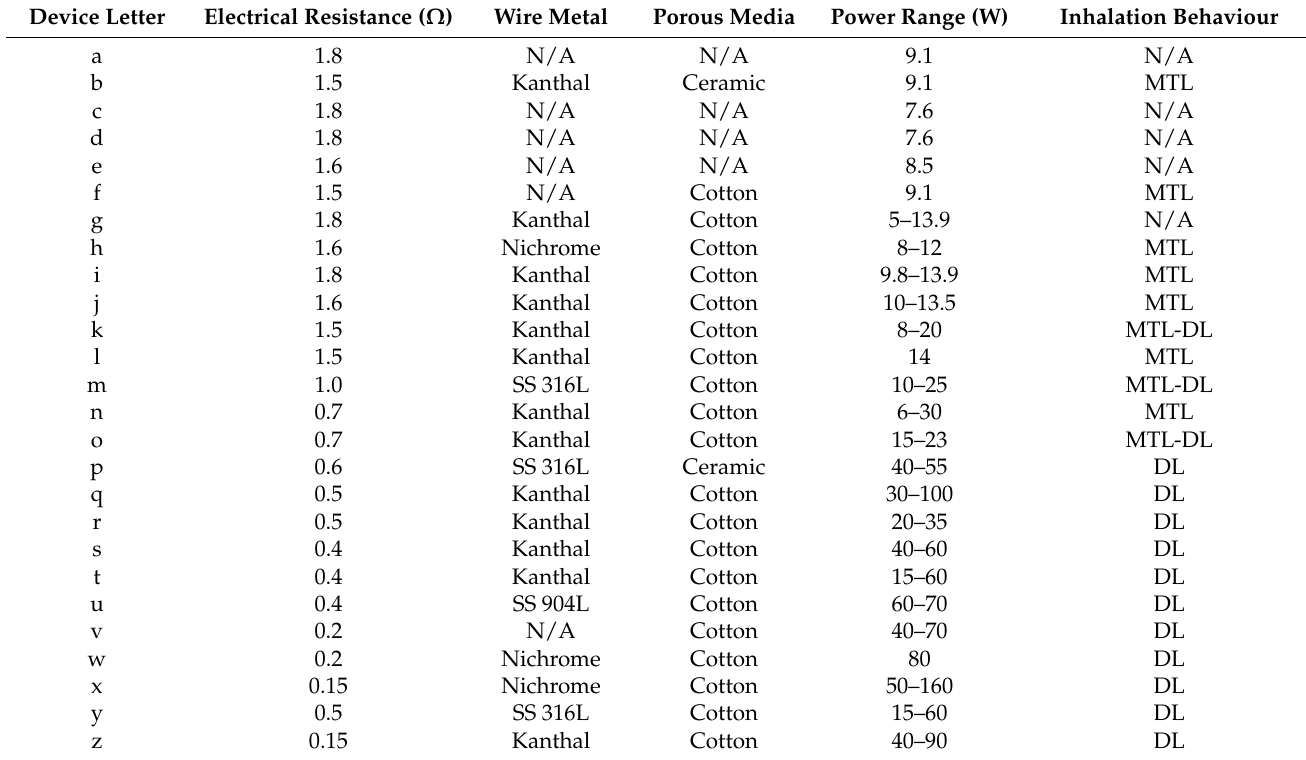
Table 2. Technical information provided by their manufacturers for the twenty-six devices—(N/A: Not Available).